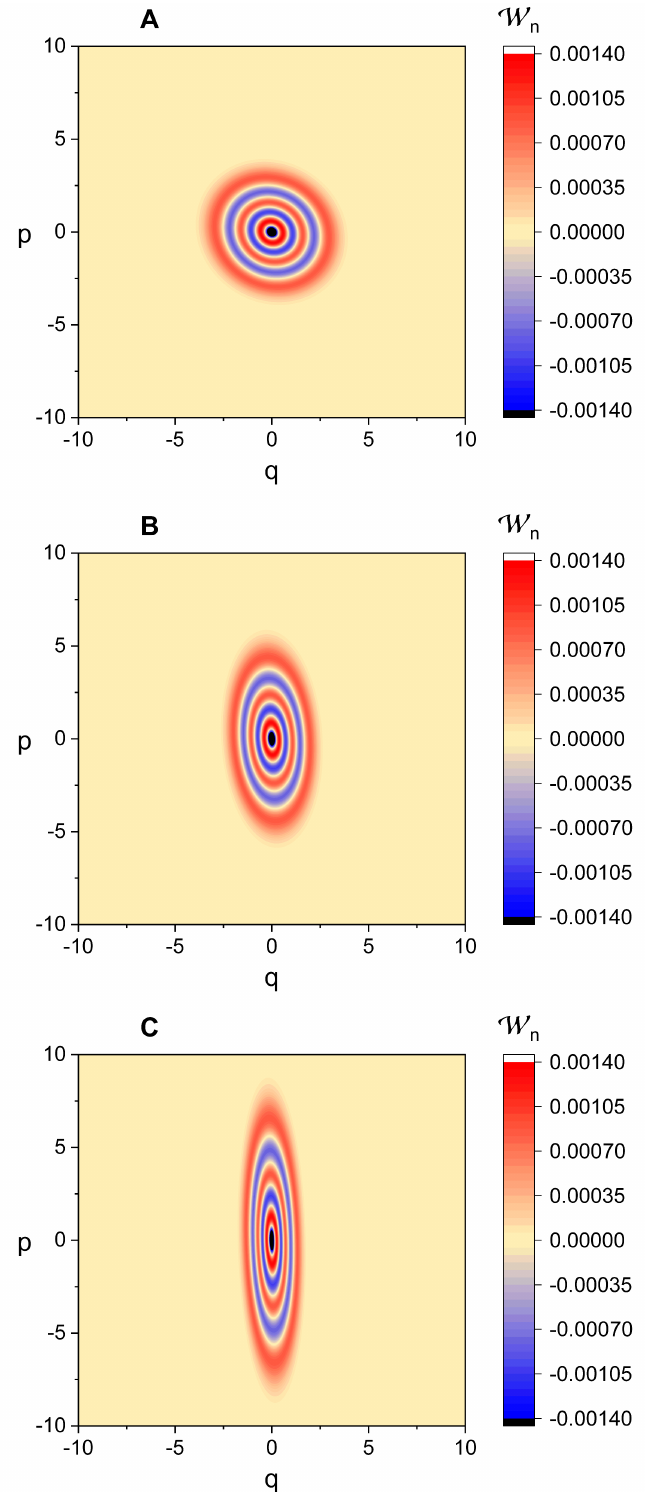
Figure 2. Contour plot of W n [Equation (6)] for several different times: we have chosen t = 0 for ( A ), t = 4 for ( B ), and t = 8 for ( C ). We used n = 5, ω 0 = 1, β = 0.2, ¯ h = 1, and (cid:101) = 1: these choices correspond to the wave in Figure